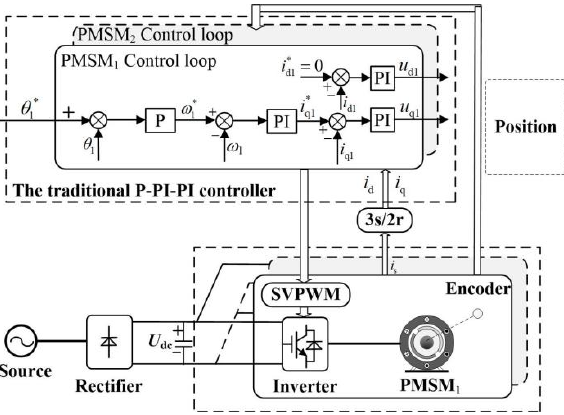
Figure 1. The structure diagram of the traditional P-PI-PI three-loop control.